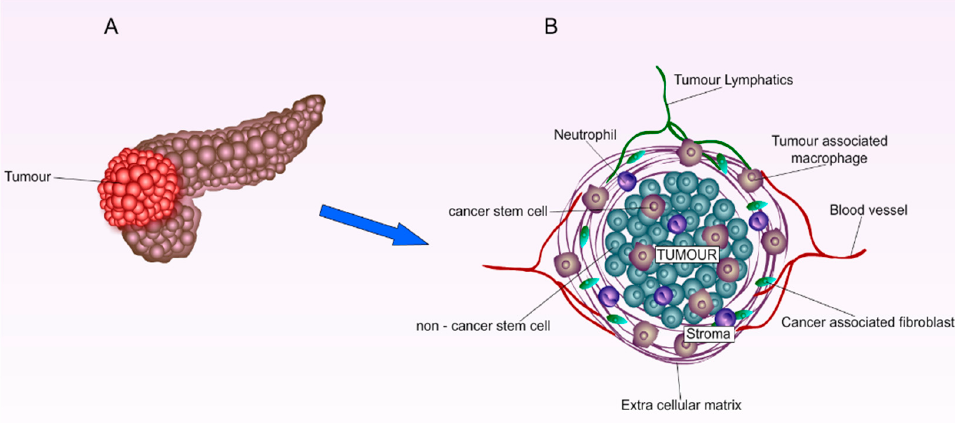
Figure 1. Graphical illustration of pancreatic tumour microenvironment. ( A ) Primary pancreatic tumour. ( B ) Enlarged pancreatic tumour environment: The cancerous cell cytokines induce the production of fibroblasts and stellate cells, leading to the build-up of the dense stroma compartment. The hostile dense and stromal structure increases intra-tumoral pressure, causing the hypo-vascularization or the collapse of blood vessels surrounding tumours. Due to the lack of a cancerous blood vessel matrix, EPR effects cannot be utilised efficiently for the delivery of systemic therapeutics.